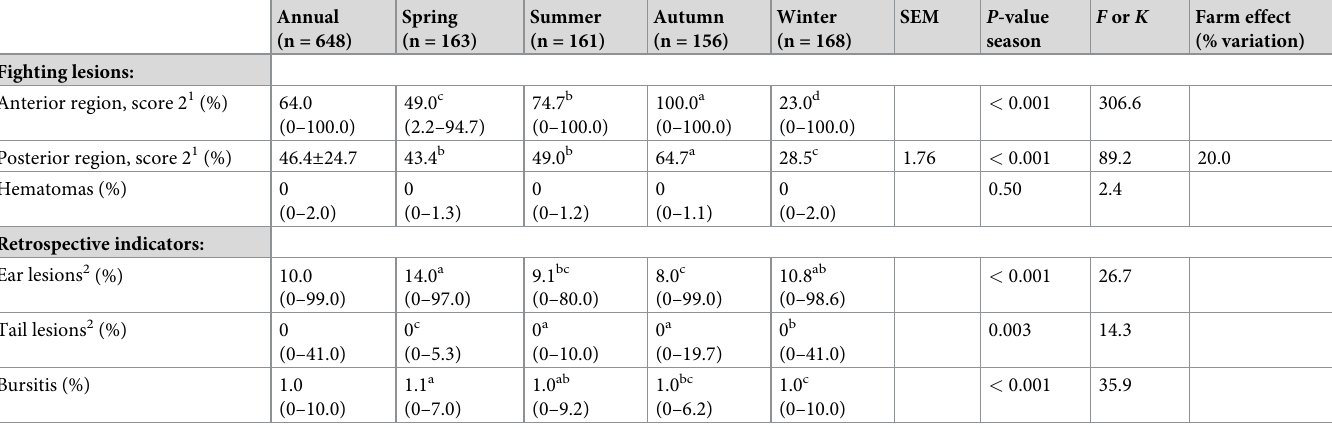
Table 1. Effect of season on the prevalence of different skin lesions detected in 648 batches of PDO Italian heavy